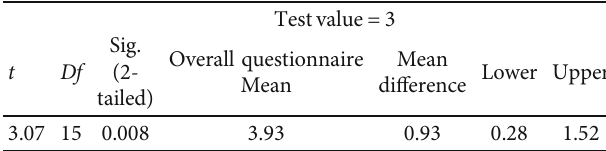
Table 7: Learners ’ attitudes as a result of the one-sample t